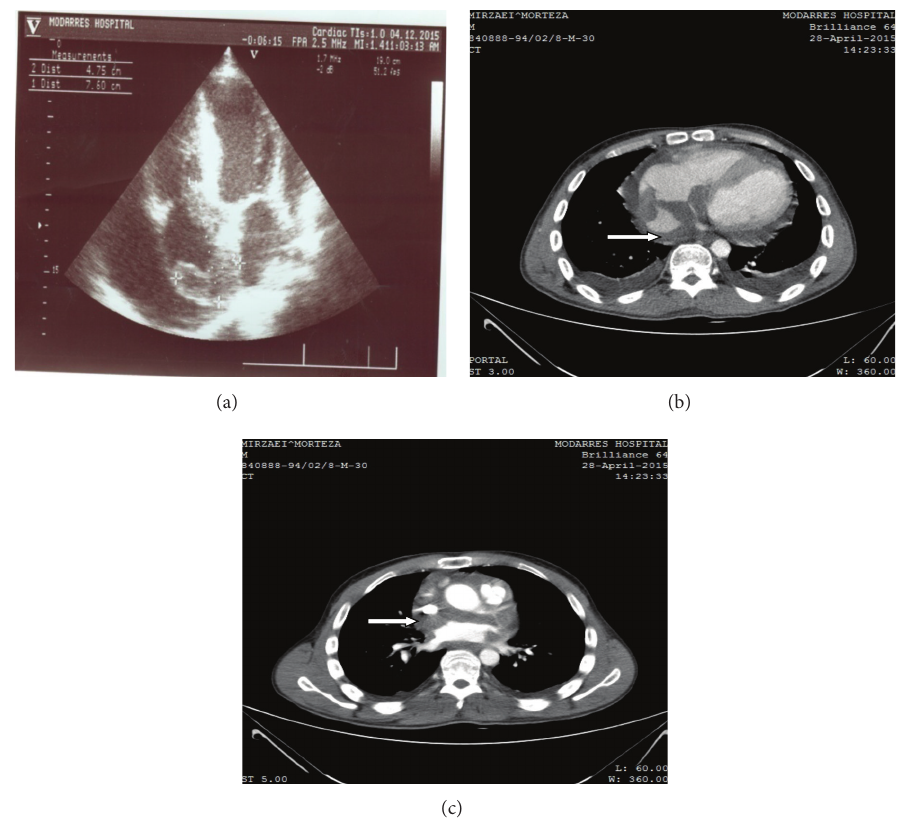
Figure 1: (a) TTE of patient which showed a large echogenic mass ( 76 mm ∗ 47 mm) in the right atrium which extended toward atrioventricular junction and septal leaflet of tricuspid valve and pericardial effusion around LV, RV, and RA with no tamponade physiology. (b and c) Spiral CT-scan of the chest with and without IV contrast which showed an infiltrative circumferential mass lesion ( white arrow ) involving the right walls of the right atrium and also interatrial septum with extension to the upper part of interventricular